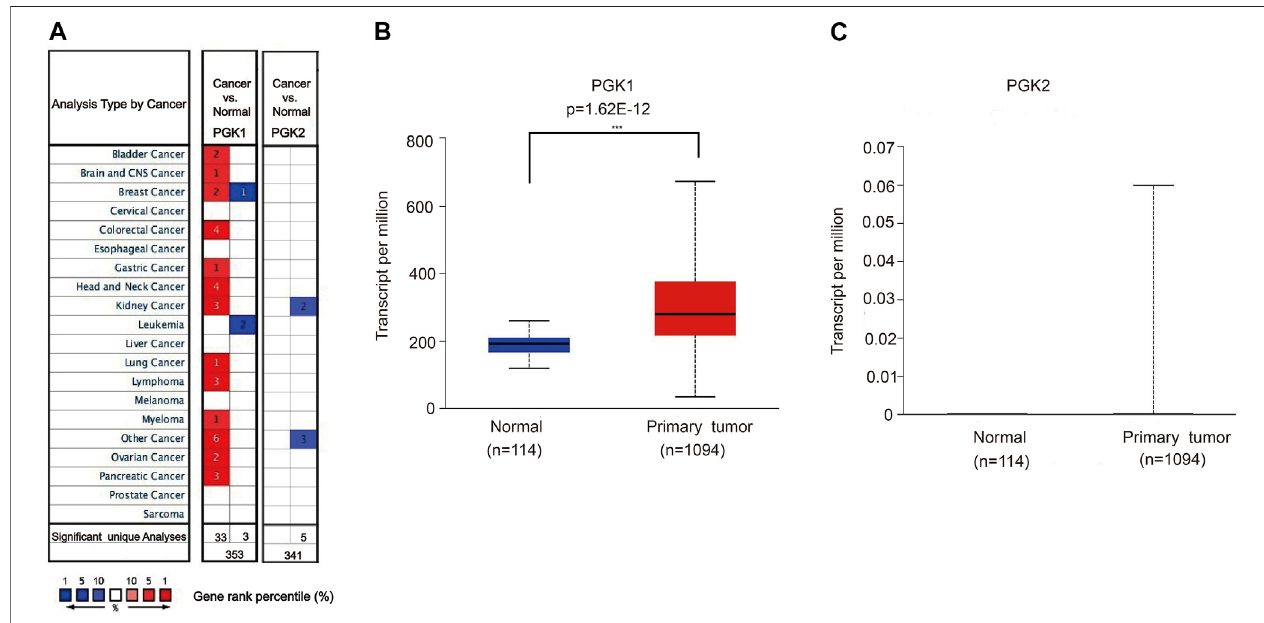
FIGURE 1 | (A) Transcriptional expressions of PGK1 and PGK2 in 20 types of cancers (cancer vs. corresponding normal tissue) were evaluated using the Oncomine database. Comparing the data by the t -test and cut-off p -value and fold change, following: p -value < 0.0001, fold change (cid:1) 2, gene rank (cid:1) 10%. Red represents signi fi cant overexpression, blue represents reduced expression. PGK1, phosphoglycerate kinase 1; PGK2, phosphoglycerate kinase 2. (B,C) High mRNA expressions of PGK1and PGK2 in patients with breast cancer and normal breast tissues by UALCAN (TCGA database), *** means p < 0.001.